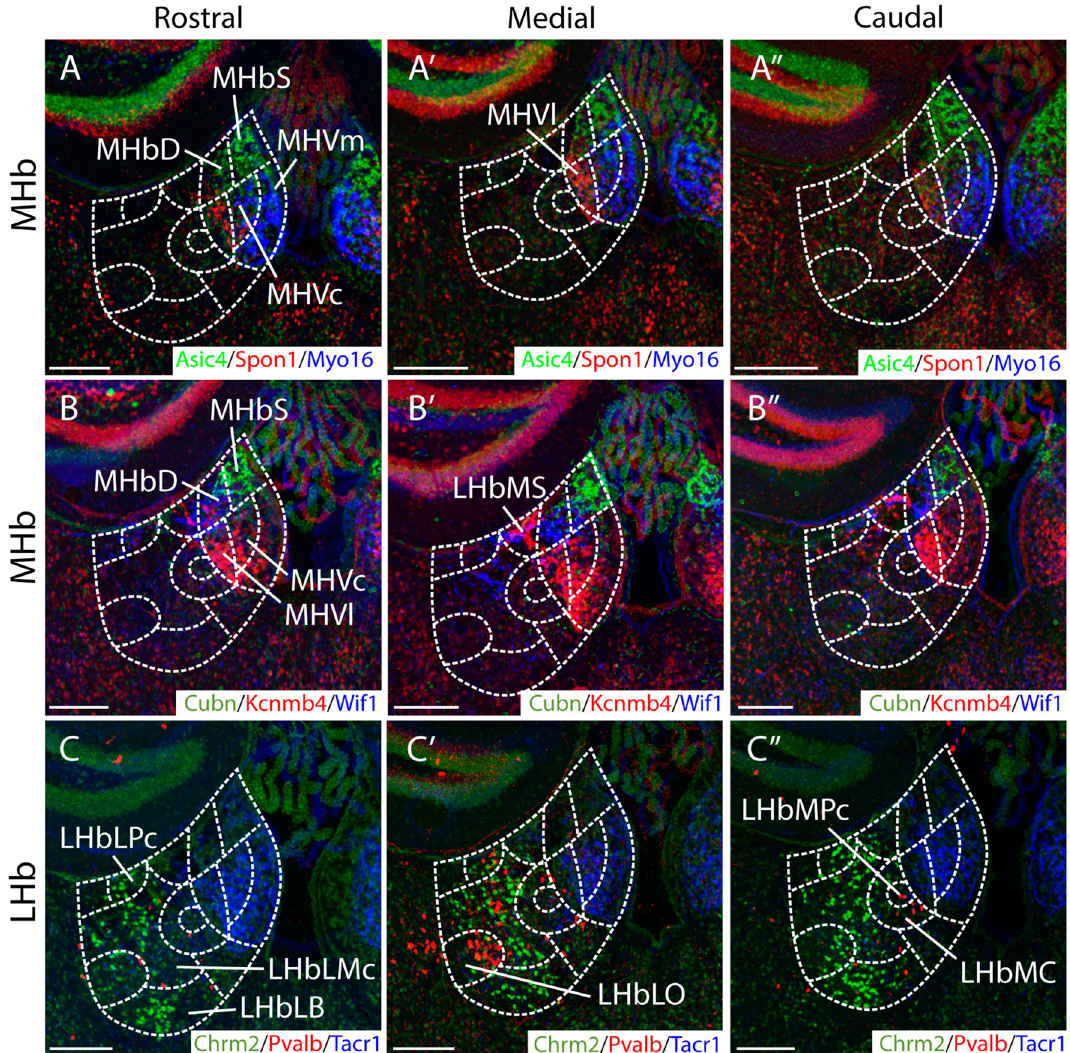
Figure 2. Transcriptomic subdivision of the habenula. ( A , A ’, A ’’) Coronal sections, from rostral to caudal, of adult mouse brain displaying fluorescence overlap of Asic4 , Spon1 and Myo16 gene expression in MHb. Asic4 is specific of MHbS and MHbD subnuclei and Spon1 is expressed in MHbVl. While Myo16 is expressed in MHBVc and MHbVm ( B , B ’, B ’’) Coronal sections, from rostral to caudal, of adult mouse brain displaying fluorescence overlap of Cubn , Kcnmp4 and Wif1 genes expression. Cubn is expressed in the MHbS while Wif1 is expressed in the MHbD. Kcnmb4 is mainly expressed in the MHbVl and MHbVc as well as in the LHbMs. ( C , C ’ and C ’’) Coronal sections, from rostral to caudal, of adult mouse brain displaying fluorescence overlap of Chrm2 , Pvalb and Tacr1 genes. Chrm2 displayed a scattered pattern in the central LHb, including the LHbLPc, LHbLMc and LHbLB subnuclei. Pvalb was expressed in the LHbLO and LHbMPc and LHbMC. Tacr1 was expressed in the three ventral components of the ventral MHb. Abbreviations: LHb, lateral habenula; LHbLB: LHbL basal subnucleus; LHbLMc: LHbL magnocellular subnucleus; LHbLO: LHbL oval subnucleus; LHbLPc: LHbL parvocellular subnucleus; LHbMC: LHbM central subnucleus; LHbMPc: LHbM parvocellular subnucleus; LHbMS: LHbM superior subnucleus; MHb: medial habenula; MHbD: MHb dorsal subnucleus; MHbS: MHb superior subnucleus; MHbVc: MHb ventral central subnucleus; MHbVl: MHb ventral lateral subnucleus; MHbVm; MHb ventral medial subnucleus. Scale bar: 200 μm. Image credit: Allen Institute for Brain Science. [https:// mouse. brain- map. the LHbMS (Fig. 2B, B’, B’’). The three ventral components of the MHb shared the expression of Tacr1 (Fig. 2C, C’, C’’). Finally, in the LHb, Chrm2 was expressed in the medial region, including the LHbLPc, LHbLMc an LHbLB (Fig. 2C, C’, C’’). While Pvalb was expressed in the LHbLO and in the LHbMPc and LHbMC (Fig. 2C, C’, C’’). Once we identified all the different subnuclei of the Hb at the three selected section levels, we proceeded with the analysis of the connectivity experiments.